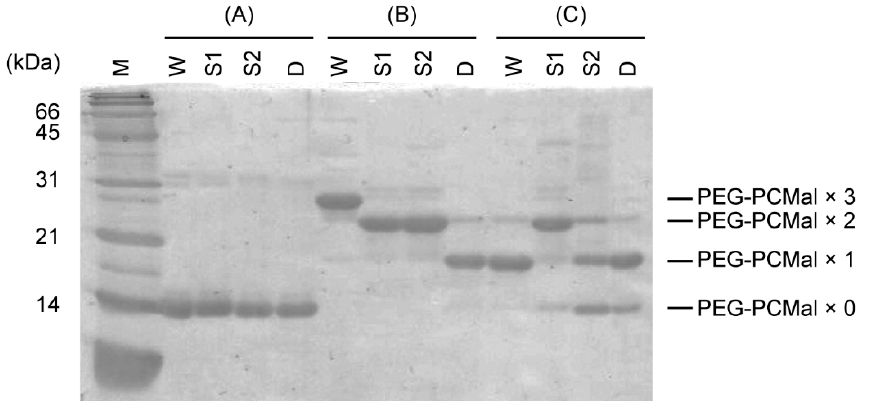
Figure 2. Band shifts of PsTrxAs on SDS-PAGE. PsTrxAs were labeled with PEG-PCMal depending on the numbers of free thiol groups. Recombinant PsTrxA proteins ( A ) were reduced by incubation with DTT, then DTT was removed by size exclusion chromatography. The resulting reduced proteins were incubated without ( B ) or with ( C ) selenite, labeled with PEG-PCMal, then resolved by SDS-PAGE. W, wild type; S1, C33A; S2, C36A; D, C33A/C36A.